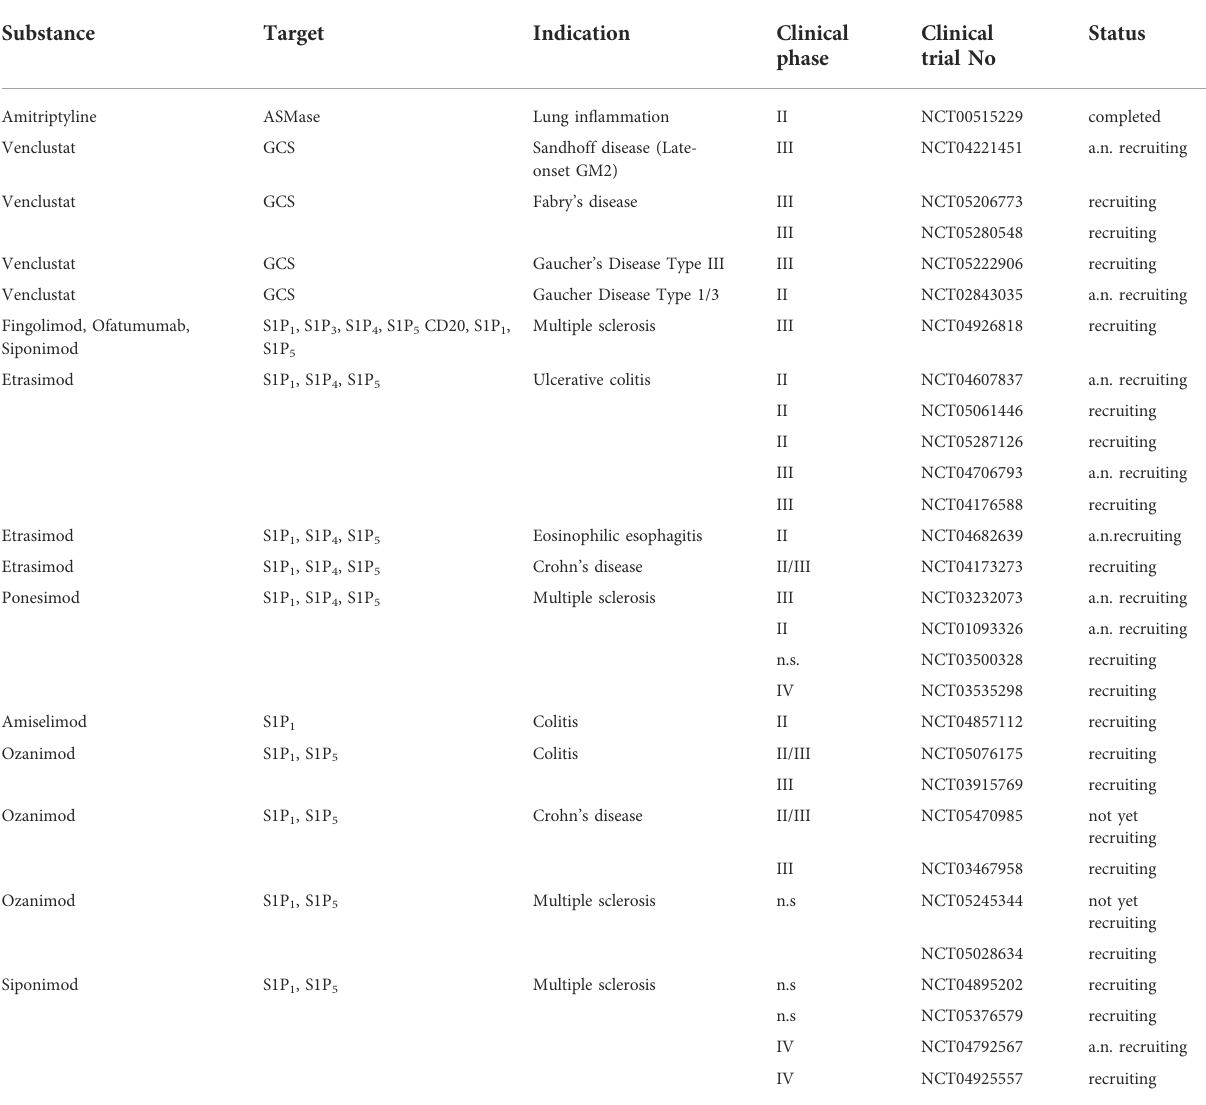
TABLE 2 Ongoing clinical trials with substances that interfere with the sphingolipid